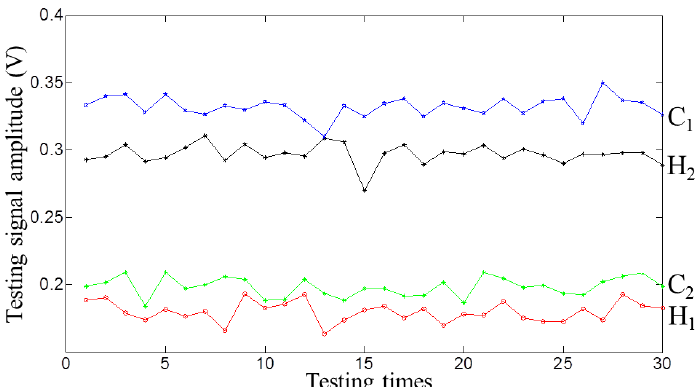
Figure 18. The testing signal amplitudes with the defects passed in different Figure18. The testing signal amplitudes with the defects passed in different paths.